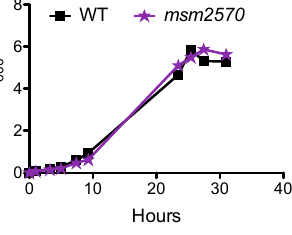
Figure 1. Growth of the msm2570::Tn mutant in 7H9 medium. Wild type ( ■ ), the msm2570::Tn mutant ( ⋆ ). Results are representative of at least two experiments.